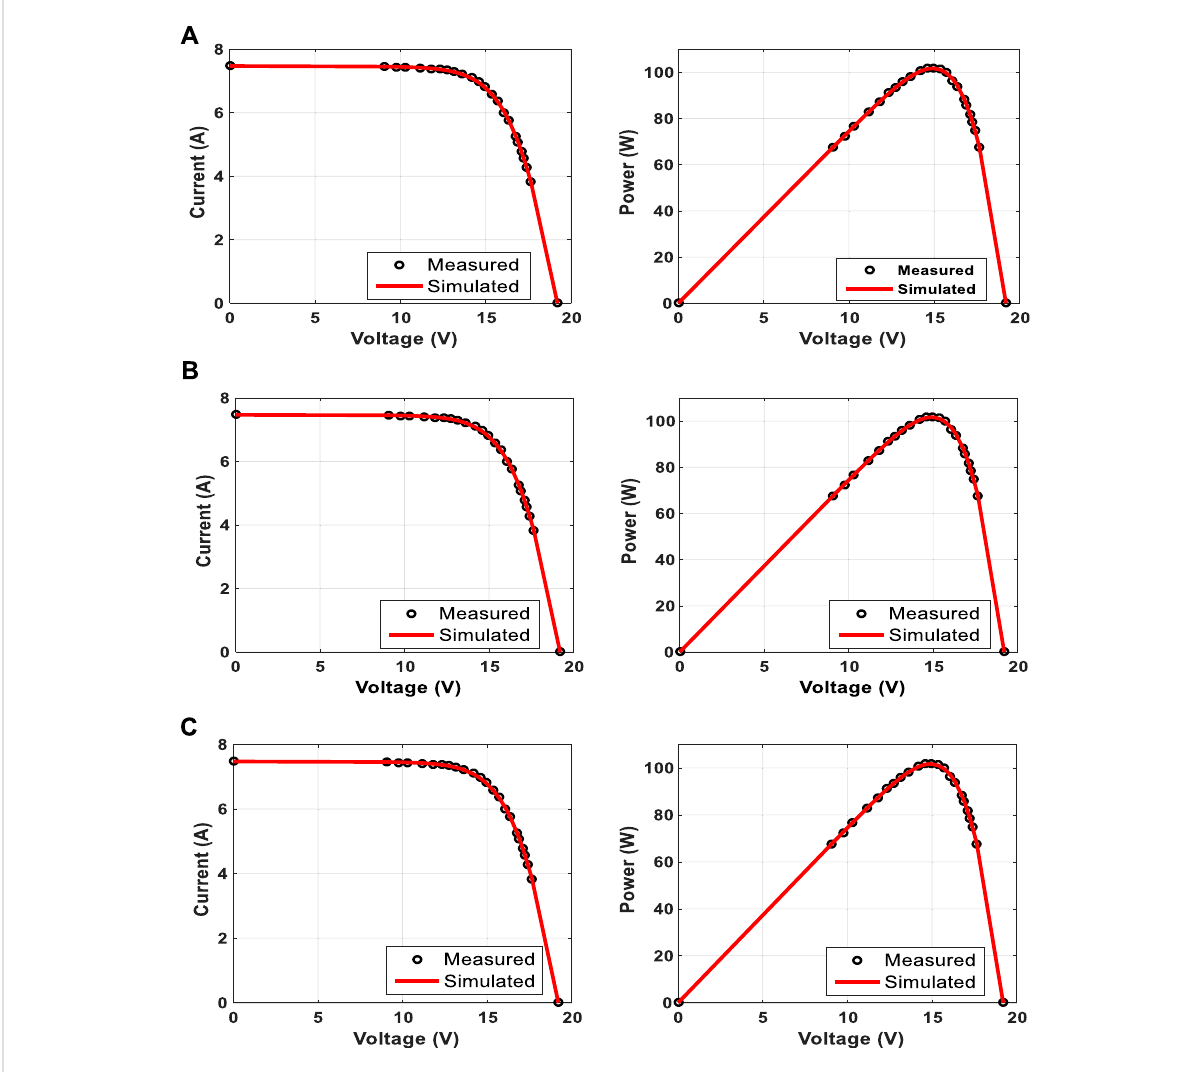
FIGURE 9 Measured and simulated I – V and P – V curves of the STP6-120/36 panel. (A) SDM, (B) DDM, and (C)